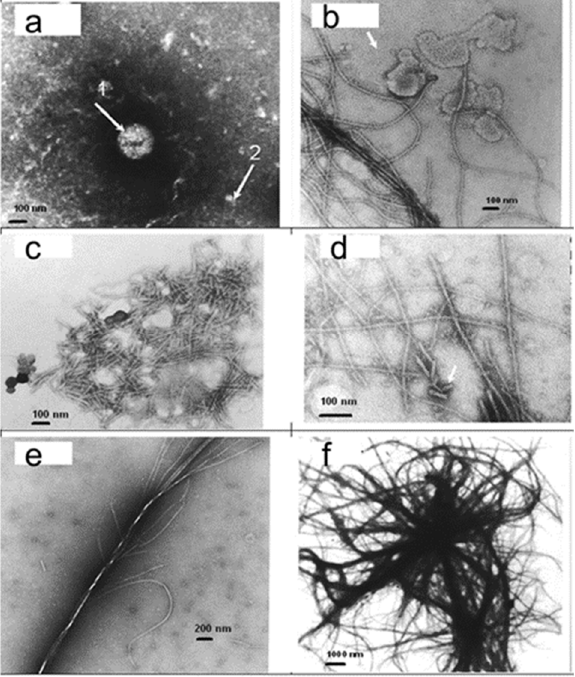
Figure 3. Effect of metal nanoparticles on crystallization of prion protein. Transmission electron microscopy. ( a ) Sample without metal nanoparticles. Arrow 1: A small number of relatively large round ball-type particles of ~300 nm. Arrow 2: A limited number of ~30 nm particles. ( b ) A large number of small particles (arrow) of 10–15 nm and filamentous structures were observed in the presence of metal nanoparticles. ( c ) Thin short rodlets (40–50 nm long). ( d ) Rodlets interconnected into longer thin filaments. ( e ) Thin filaments are interwoven into the thicker fibril. ( f ) Large fibrils create a system of fibrils and plaques.